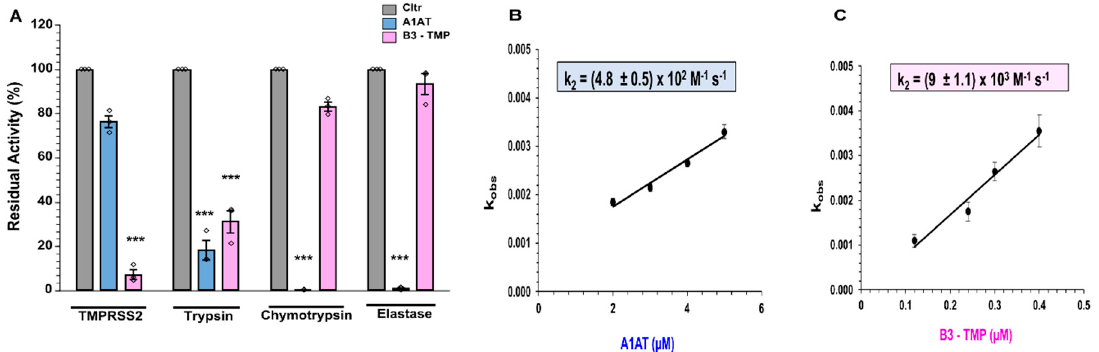
Figure 5. ( A ) B3-TMP variant is more effective than A1AT. B3-TMP was compared to A1AT in inhibiting TMPRSS2, trypsin, chymotrypsin, and elastase in protease assays. The means ± SE from n = 3 independent experiments. One-way ANOVA with Tukey’s comparison test: *** p < 0.0005. ( B , C ) Second order rate constant, k 2 . The residual initial velocity of substrate cleavage by TMPRSS2 (0.1 μ M) was determined over time following incubation with various concentrations of ( B ) A1AT and ( C ) B3-TMP. The natural logarithm of the residual activity (ln(E)) was plotted against the time points (s) and data fitting was performed with linear regression analysis. The slopes of these lines represent -k obs . This k obs is replot against serpin concentration to yield the second order inhibition rate constant (k 2 ).